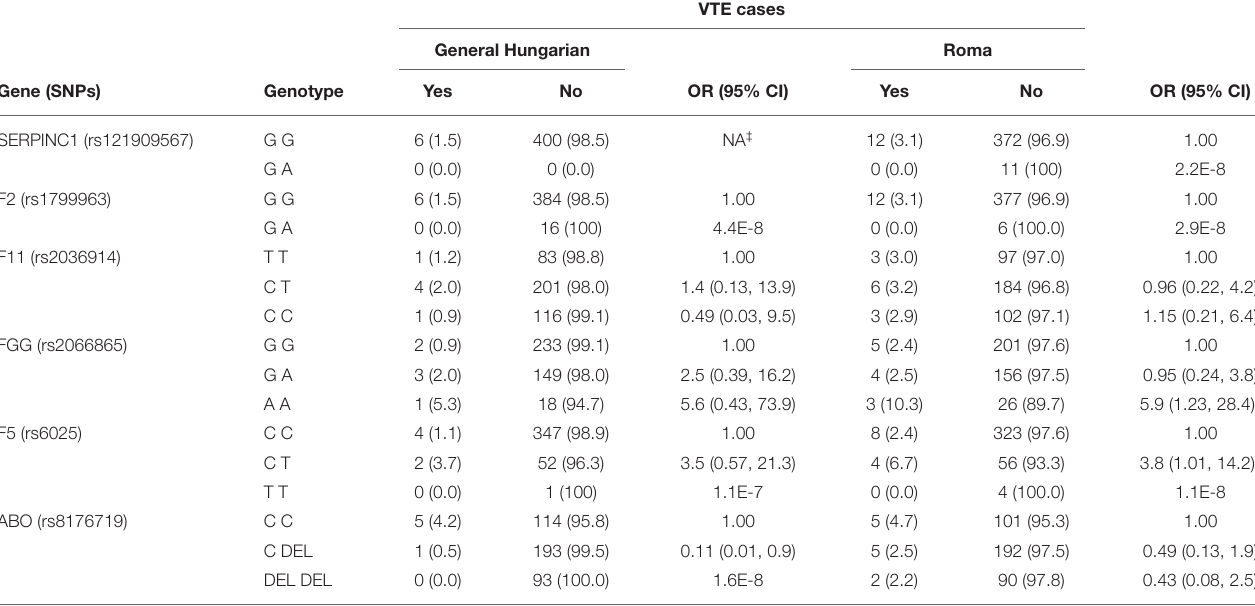
TABLE 4 | Comparisons of associations between individuals SNPs and VTE in the general Hungarian and Roma populations.